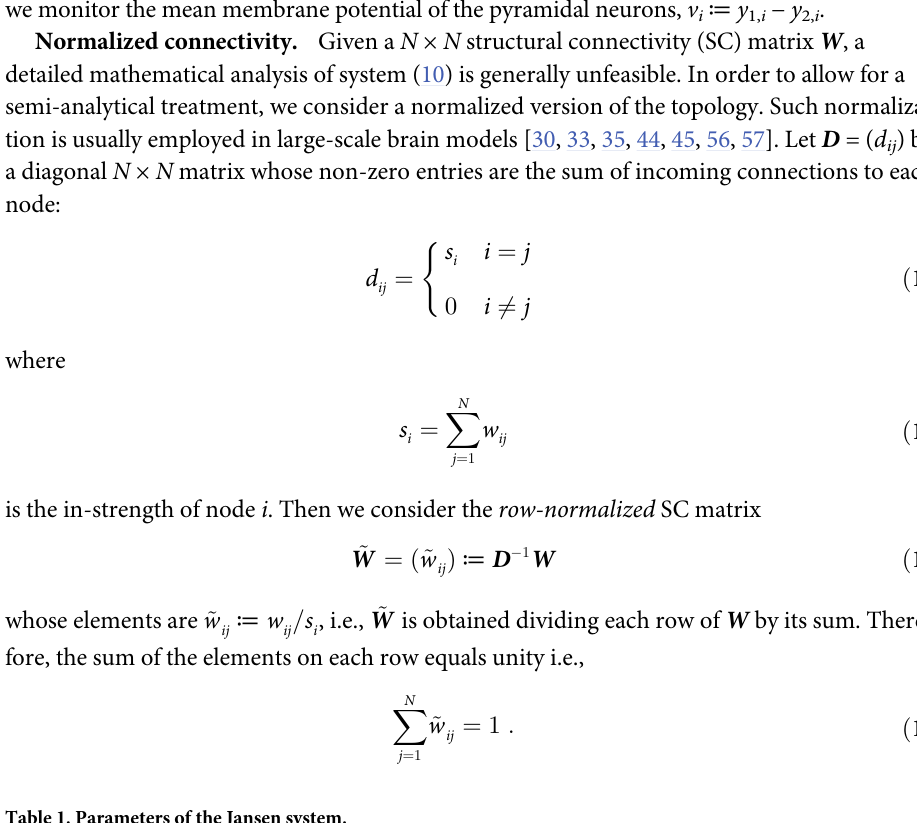
Table 1. Parameters of the Jansen system. Parameter Meaning Value A Maximal amplitude of excitatory post-synaptic potentials 3.25mV B Maximal amplitude of inhibitory post-synaptic potentials 22mV a Characteristic decay time for ePSP 100s − 1 b Characteristic decay time for iPSP 50s − 1 C 1 , C 2 , C 3 , C 4 Synaptic strength (average number of synapses) between populations 135, 108, 33.75, 33.75 e 0 Half of the maximum firing rate 2.5Hz Potential where half the maximum firing rate is achieved Neuronal excitability Connectivity weights from data p Constant baseline firing rate to pyramidal neurons not fixed (Hz) Coupling